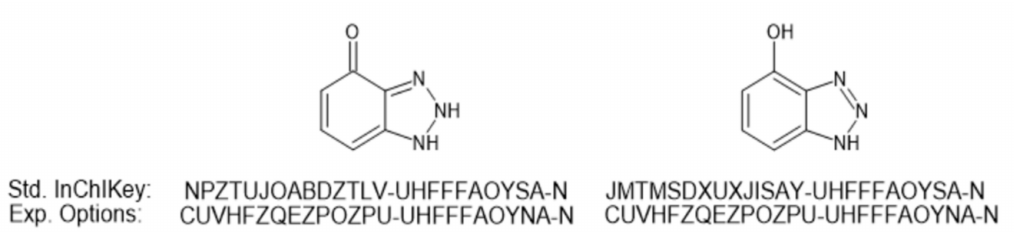
Figure 1. The standard InChIKeys for the tautomeric keto and enol forms of 4-hydroxybenzotriazole. Also indicated are the experimental InChIKeys generated using ACD / ChemSketch to account for keto-enol